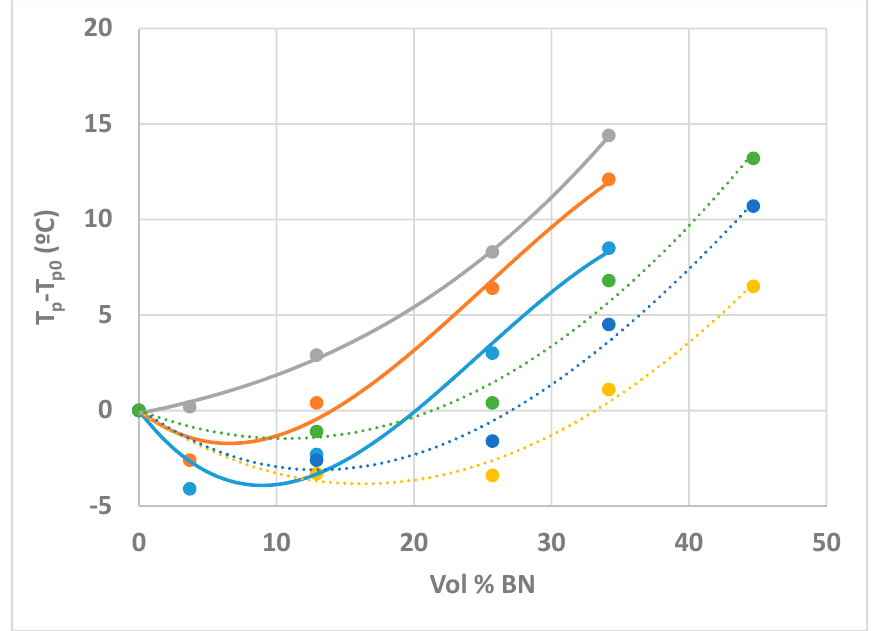
Figure 3. Plot of T p − T p0 as a function of vol % BN for the systems ETLBN80 and ETLBN6, respectively, at the heating rates of 2 (dark blue, purple), 5 (red, light blue), and 10 K/min (green, orange). The curves are drawn to guide the eye: full lines for ETLBN80, dotted lines for ETLBN6.